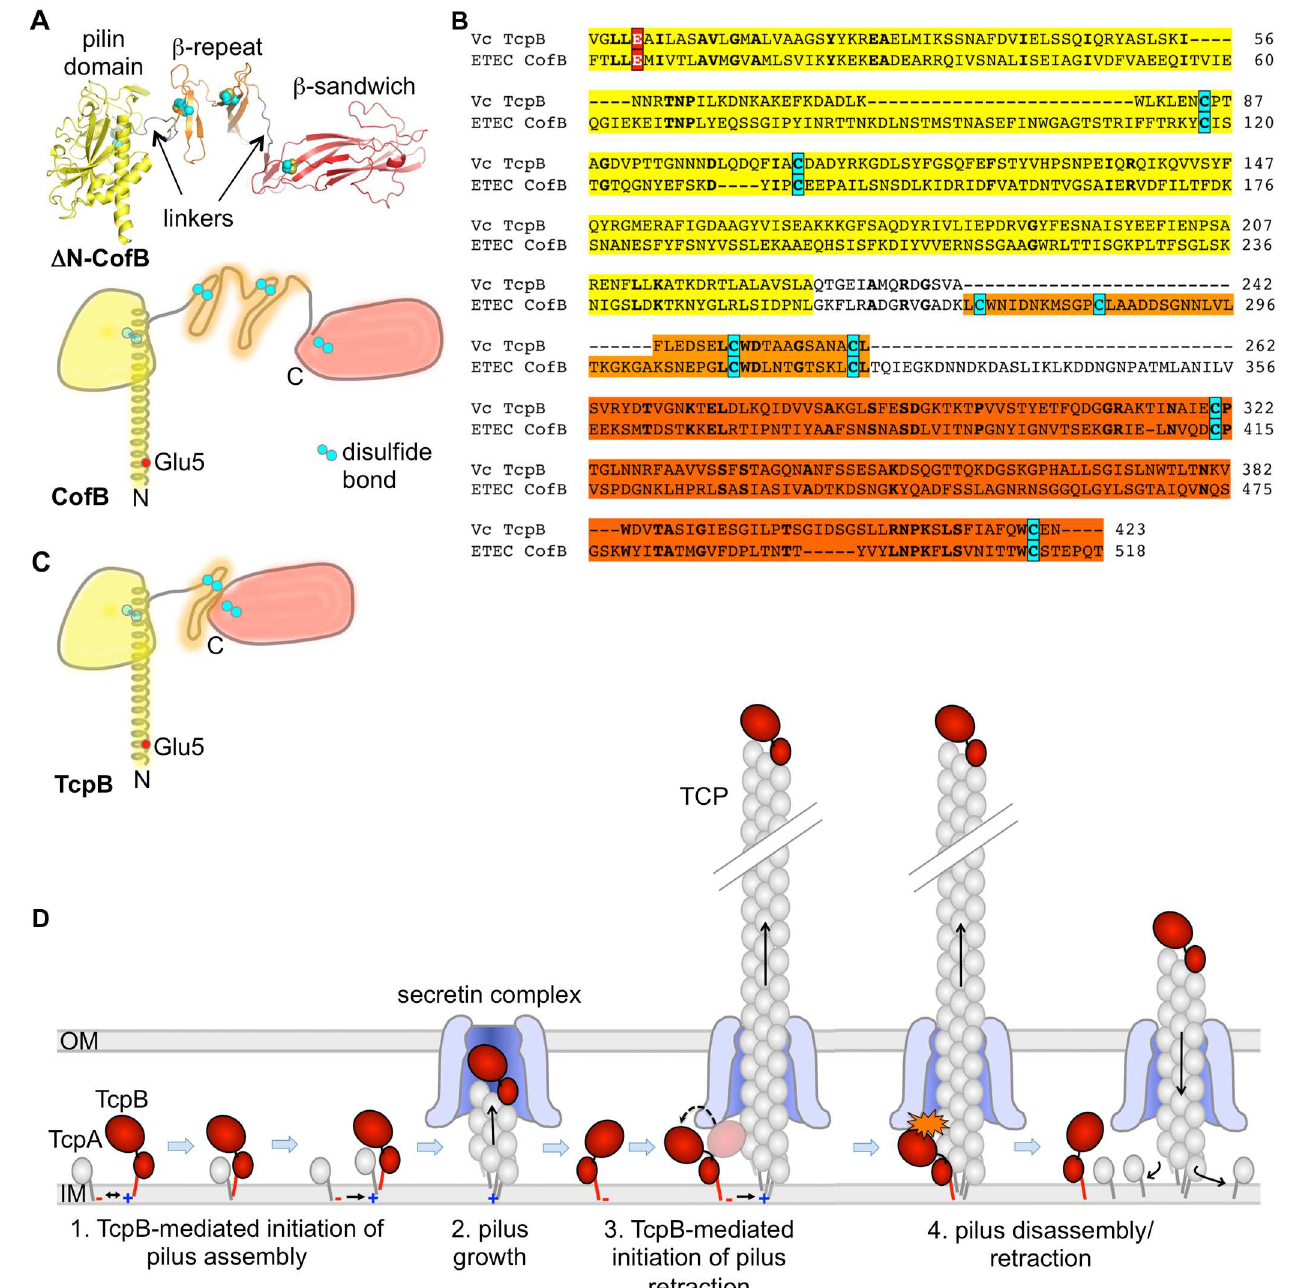
Fig 8. Comparison of TcpB and the ETEC minor pilin CofB and model for TcpB-mediated assembly and retraction. (A) Crystal structure of N-terminally truncatedCofB (4QS4 [98]) shown in cartoon representation (top), and as a schematic (bottom) with the full N-terminal α -helix. Cysteinesare coloredcyan. (B) Amino acid sequencealignmentof TcpB and CofB (NCBI Accession BAB62898). Alignment was first performed using Clustal Omega [110] then adjustedto align the cysteines. Identicalresidues are shown in boldfacetype. The conservedGlu5 (red with white text) and cysteines (cyan) are indicated. Discrete domainsare shadedbased on the coloring of CofB shown in (A). (C) Proposed schematic of the TcpB structure basedon sequencealignmentwith CofB. (D) Model for TcpB-mediated initiationof pilus assembly and retraction. TcpB is representedas a pilin domain(red stick and small oval) with an additionalC-terminal domain (large oval). Incorporation of TcpB into the growing pilus may block passageof the pilus through the secretin complex as shown (Steps 3, 4) or may prevent further incorporation of TcpA. If pilus assembly cannot proceed,the pilin subunitswill melt back into the membrane, one subunit at a time, retracting the pilus.